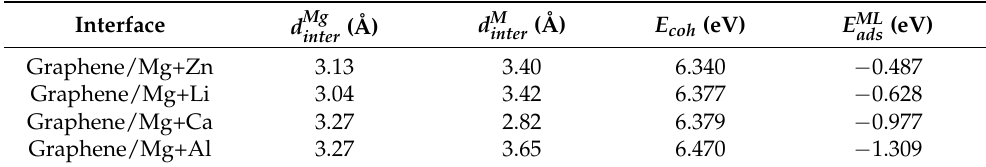
Table 1. DFT-calculated interfacial distance ( 𝑑 𝑖𝑛𝑡𝑒𝑟 ) and cohesive energy ( 𝐸 𝑐𝑜ℎ ) of graphene/Mg + M interfaces.